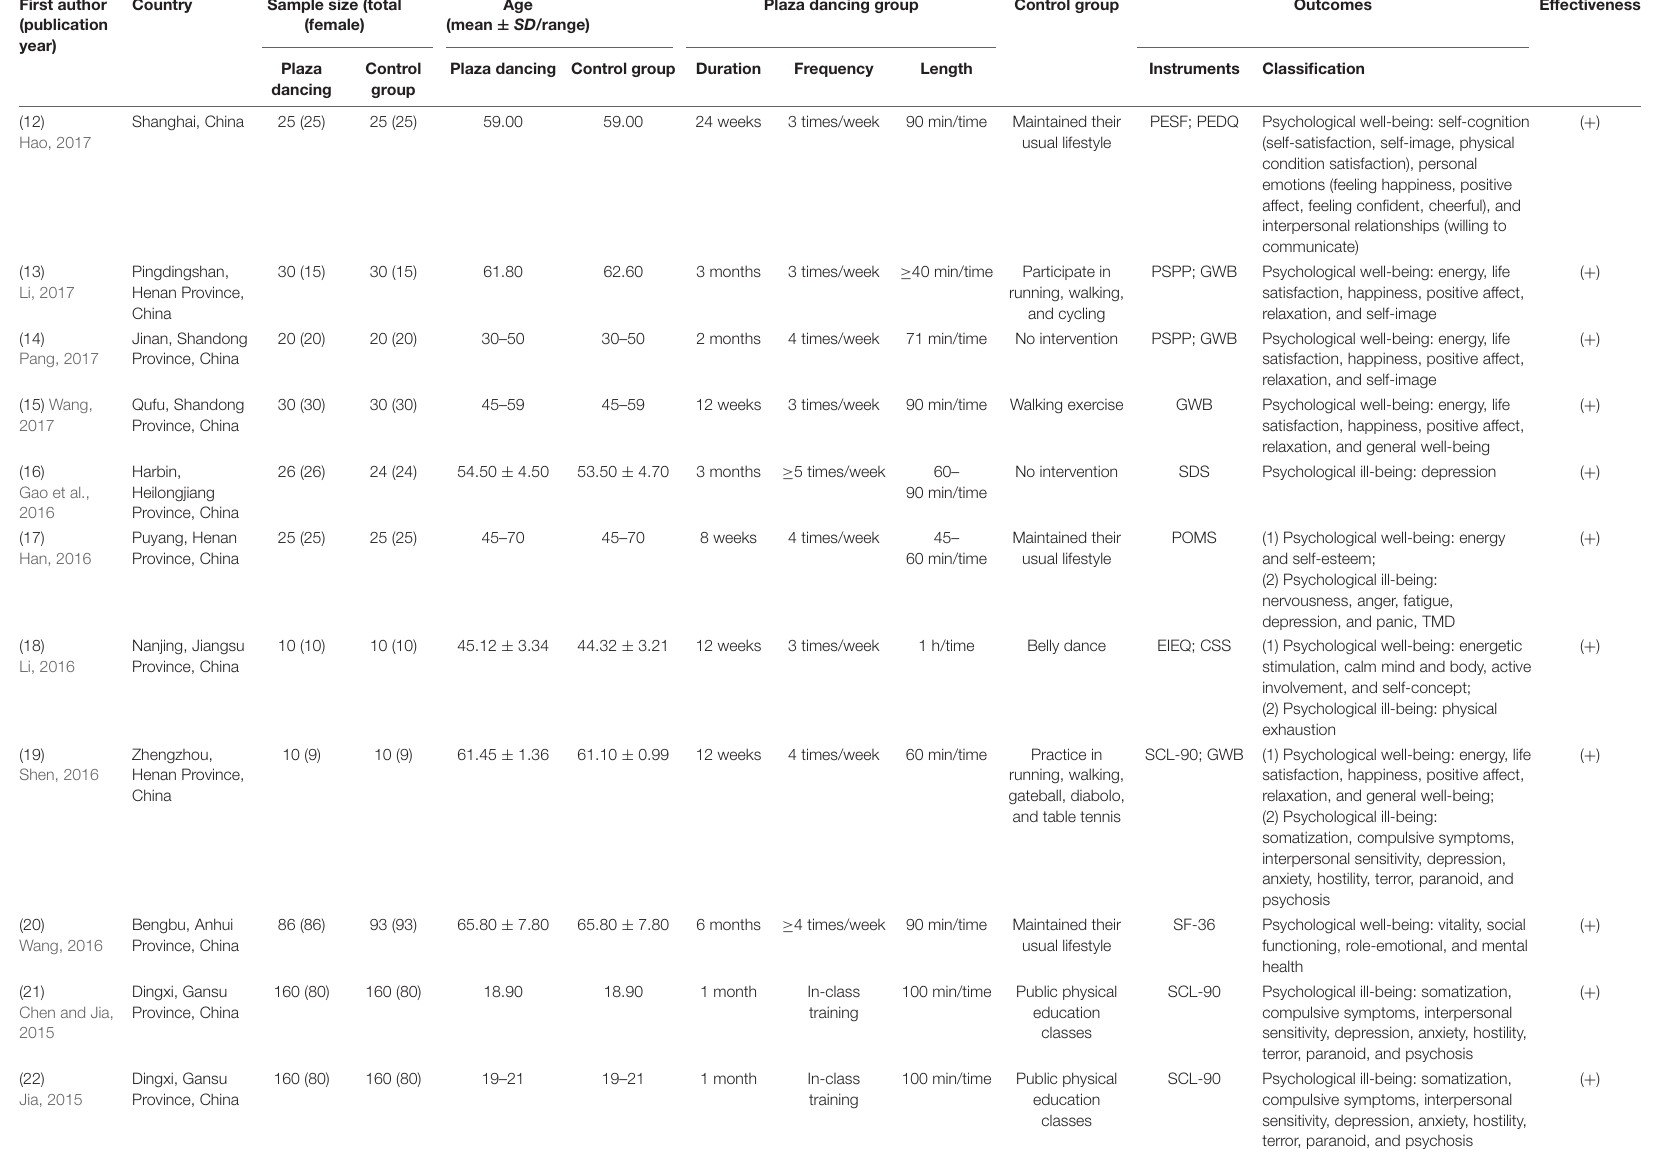
PESF; PEDQ Psychological well-being: self-cognition (self-satisfaction, self-image, physical condition satisfaction), personal emotions (feeling happiness, positive affect, feeling confident, cheerful), and interpersonal relationships (willing to